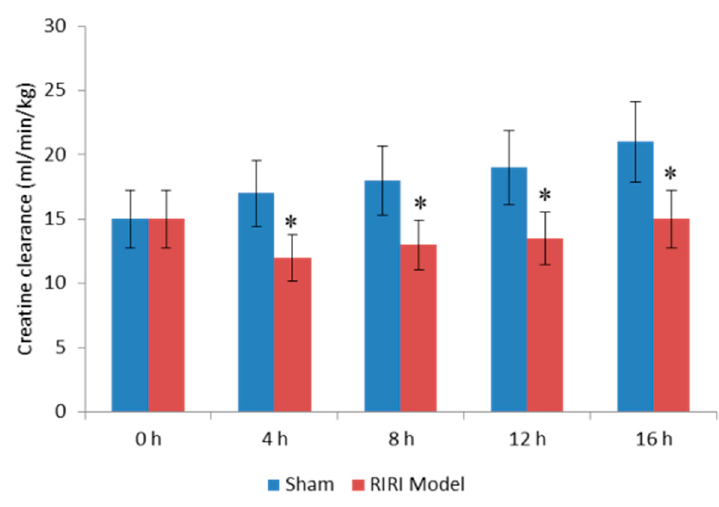
Figure 1. Creatinine clearance rate in mice. RIRI, Renal ischemia-reperfusion injury. All data were presented as mean values ± S.D. n = eight in each group. * p < 0.05 compared to the sham group.